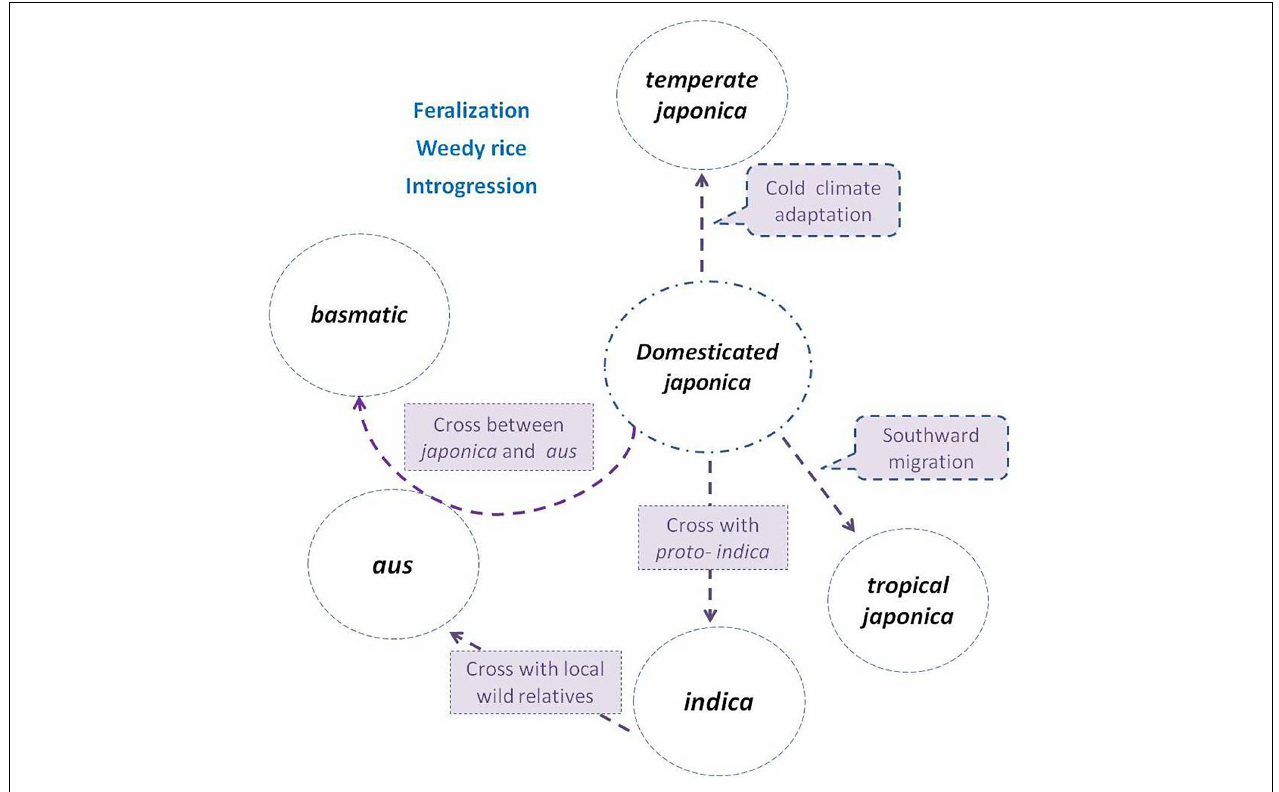
FIGURE 1 | Subgroup differentiation of Oryza sativa in the evolution process. The japonica rice (circle in the center) was domesticated first from Oryza rufipogon , then divided northward as temperate japonica , and south ward as tropical japonica . The indica was descent from hybridization between japonica and local wild populations or proto-indica. The aus was derived from the hybridization between indica and local wild populations, while the basmatic was derived from hybridization between japonica and aus . Weedy rice strains de-domesticated from and coexisted with cultivated subgroups, and frequently crossed with wild populations (if present) or landraces during their evolution